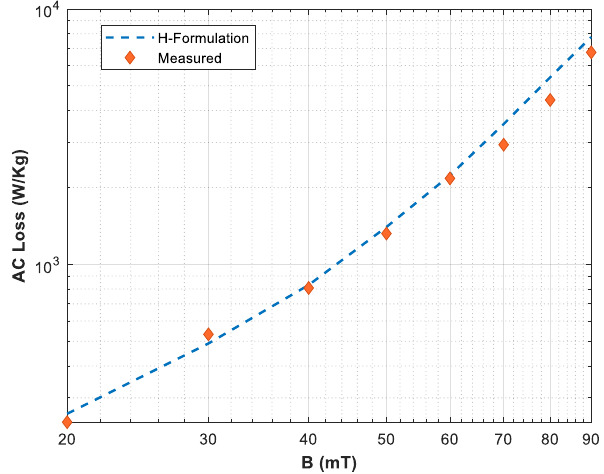
Figure 5. AC loss with rotating magnetic excitations up to 90 mT.